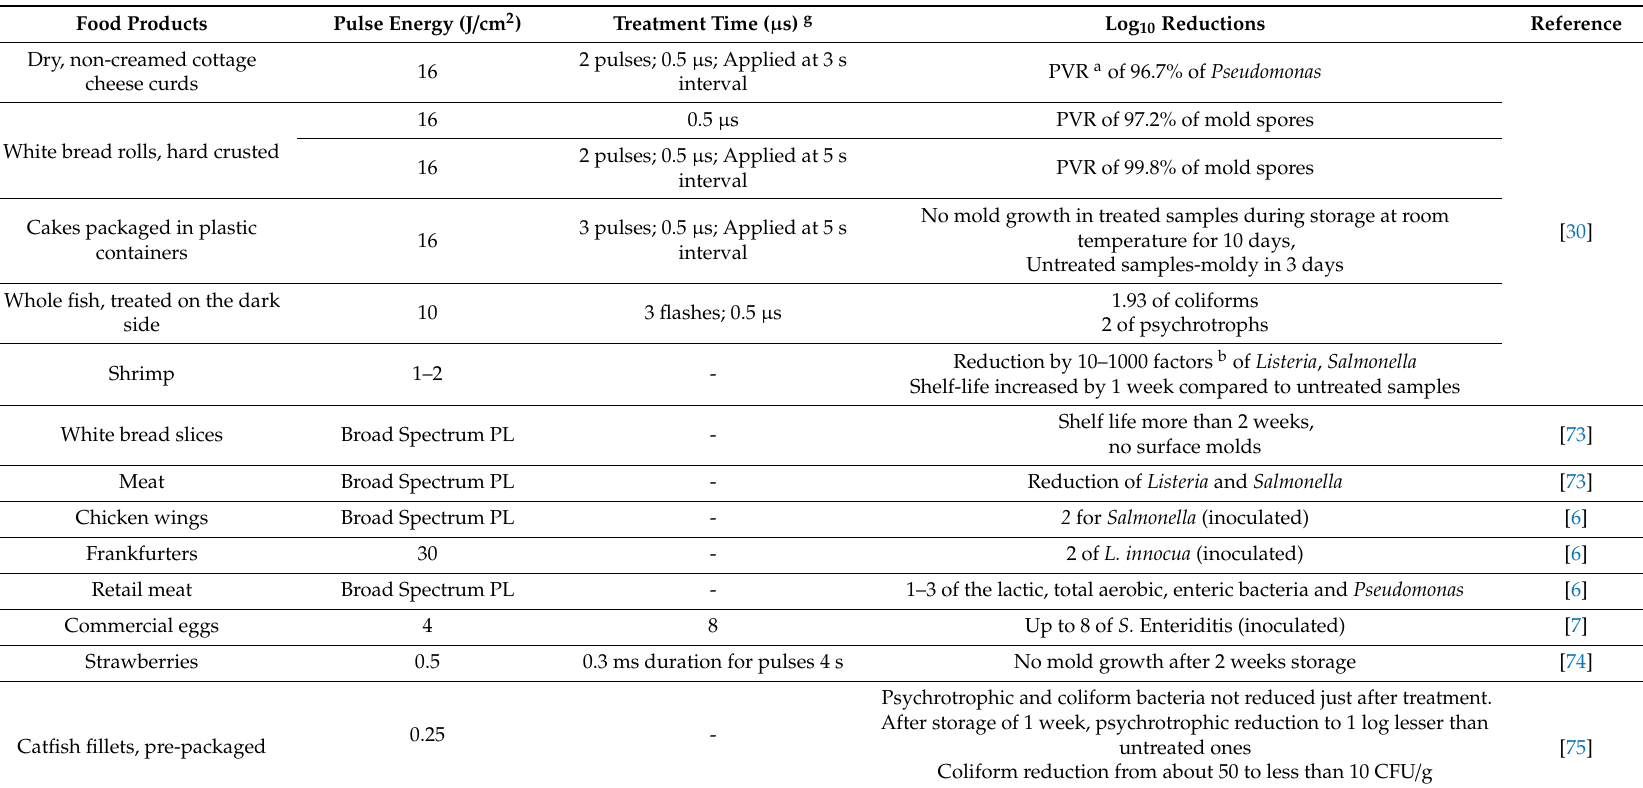
Table 4. The e ff ects of PL on some food products based on several published